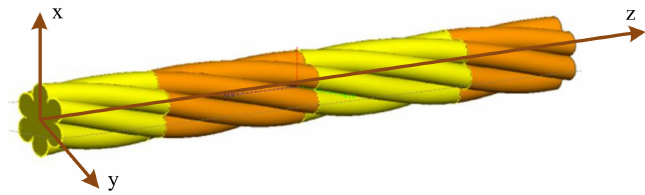
Figure 2. Grouping of power lines along the long axis ( z